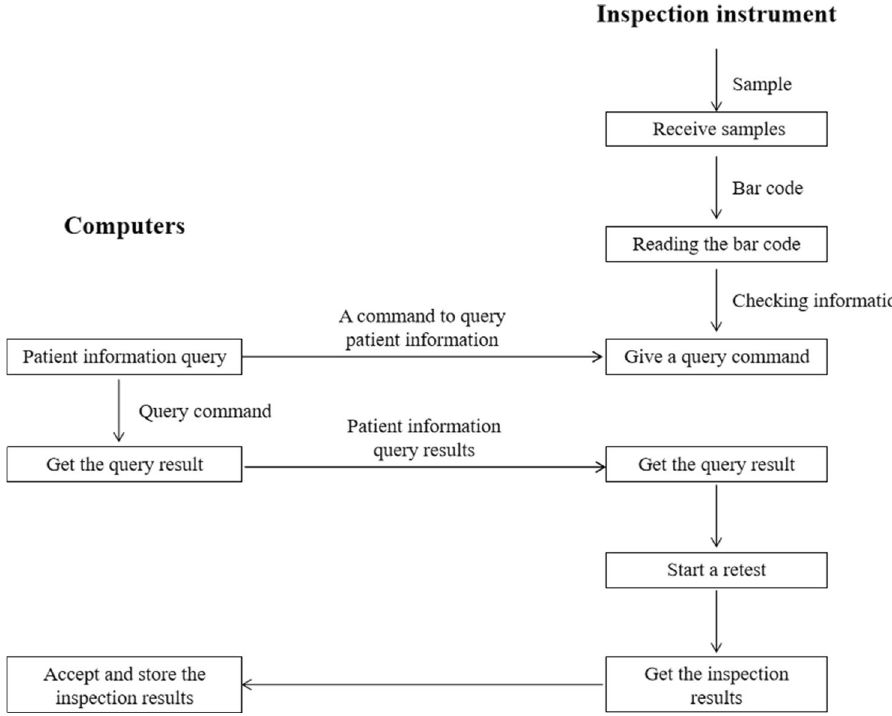
Fig. 1 Two-way communication flow